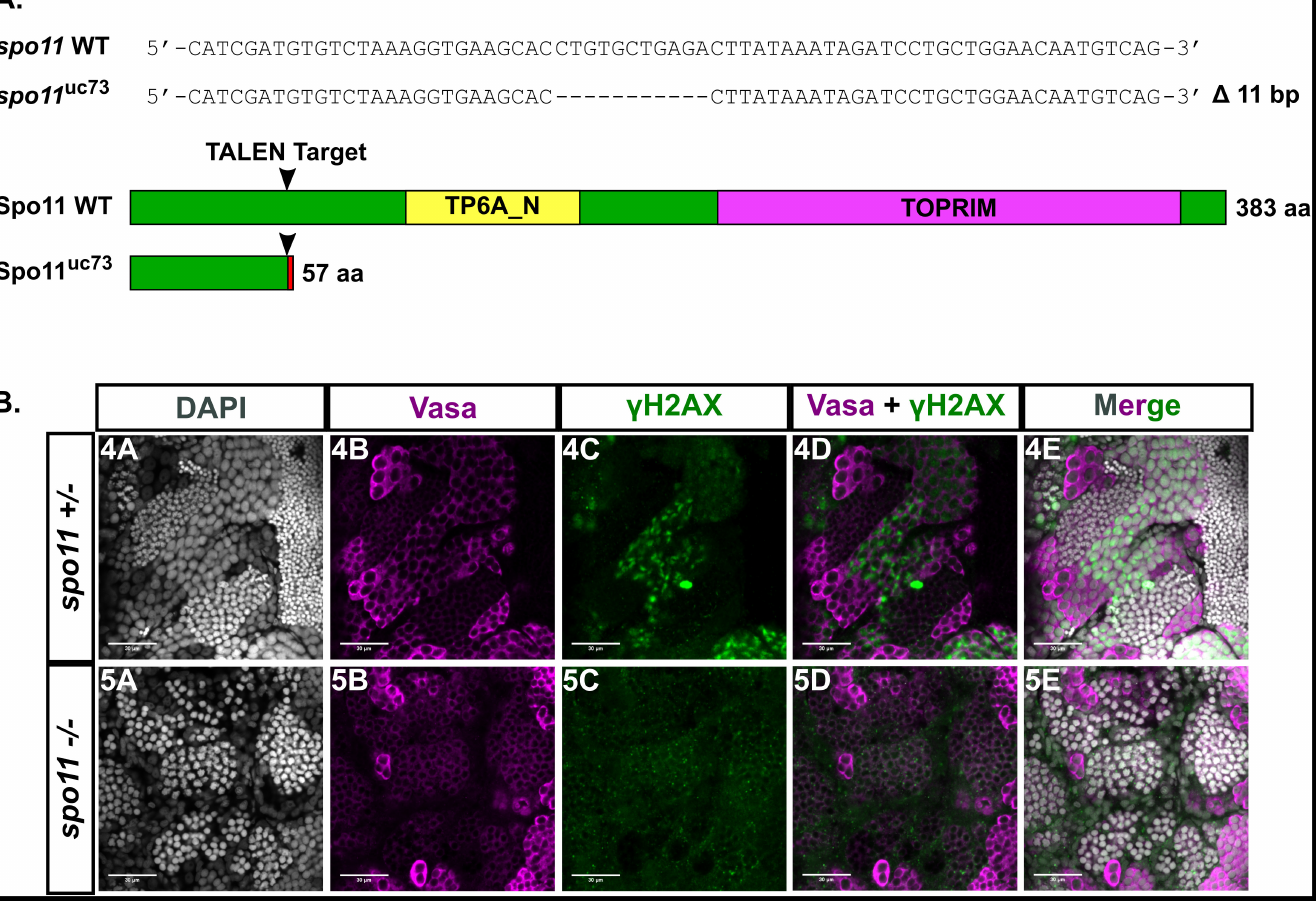
Fig 7. A: TALEN generated 11 bp frameshift mutation allele ( spo11 uc73 ) leads to a truncated 57 aa Spo11 protein with the conserved TP6A_N and TOPRIM family domains deleted. B: Whole testes stained for vasa (magenta), γ H2AX (green), and DAPI (gray). spo11 +/- testes show a normal pattern of γ H2AX staining whereas the pattern is disrupted in the spo11 -/-